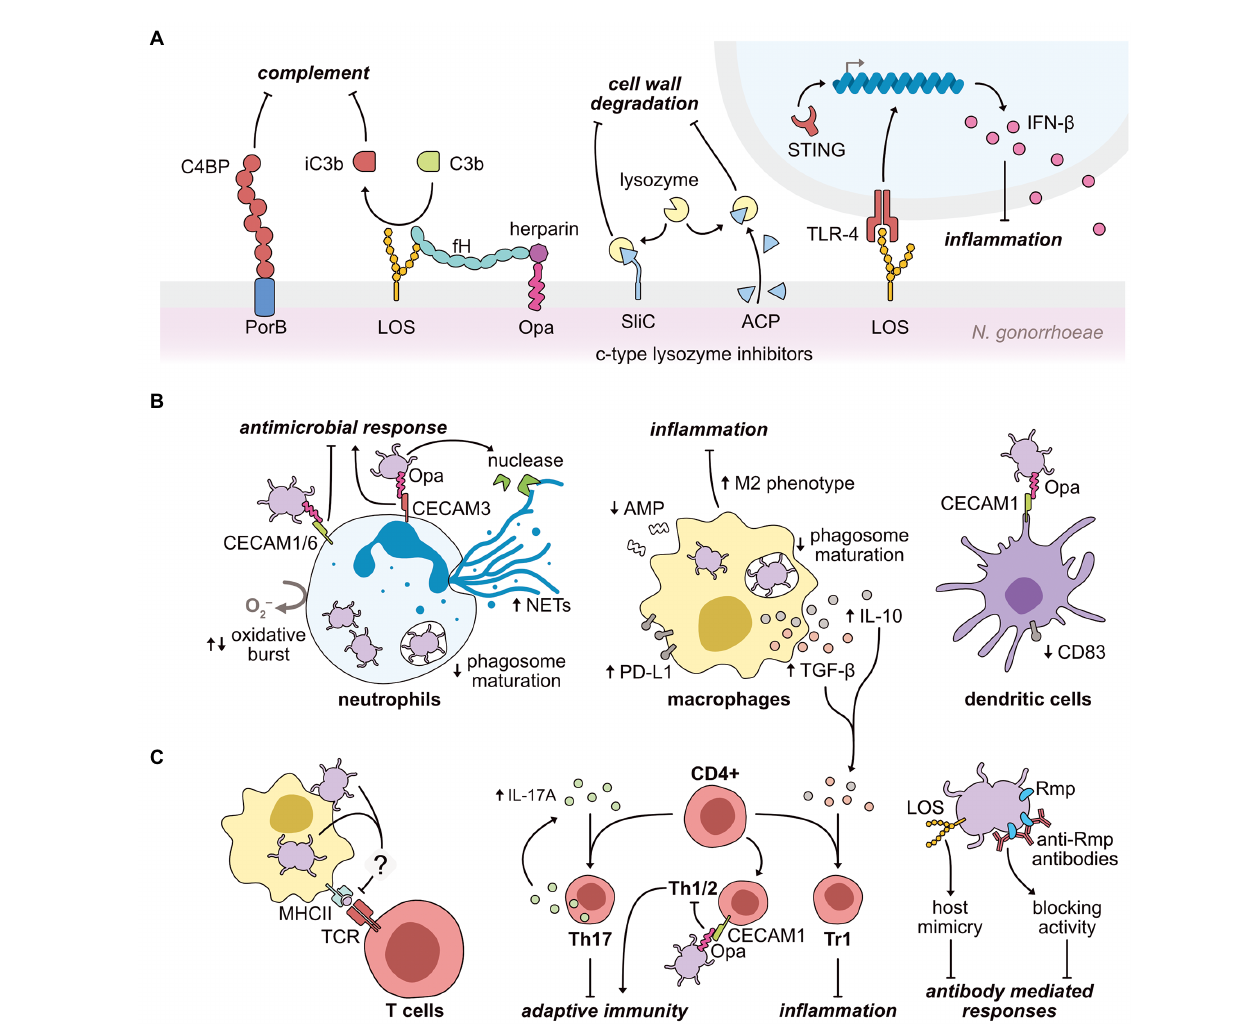
FIGURE 2 Modulation mechanisms exerted by N. gonorrhoeae on the host immune response during infection. (A) Gonococci use their primary outer membrane antigens to limit the efficacy of host lysozyme, complement, and pattern recognition systems. PorB and sialylated LOS interact with the soluble complement inhibitory proteins, C4BP and factor H (fH), respectively. LOS also binds to the soluble complement protein, C3b, inducing its inactivation (iC3b). Gonococcal Opa proteins further interact with host heparin to promote C3b inactivation. The gonococcus also expresses two surface-exposed lysozyme inhibitors (SilC and ACP), preventing the bactericidal activity of host lysozyme upon infection. In parallel, LOS interaction with the pattern recognition receptor, TLR-4, upregulates the expression of the anti-inflammatory cytokine, IFN- β . Gonococci-induced upregulation of IFN- β also occurs via activation of the cytosolic pattern recognition receptor, STING. (B) Gonococci repress antimicrobial functions of key innate effector cells to promote infection. The gonococcus engages with CEACAM receptors on neutrophils via its Opa proteins to repress (Opa-CEACAM1 and Opa-CEACAM6) or activate (Opa-CEACAM3) inflammatory responses, such as the oxidative burst. Neutrophil extracellular traps (NETs) are upregulated by gonococcal infection, although the secretion of a gonococcal nuclease may aid gonococci in resisting NET action. In both neutrophils and macrophages, gonococci are adept at delaying phagosome maturation to prolong intracellular survival. To specifically limit macrophage function, gonococci downregulates antimicrobial peptide (AMP) expression, while simultaneously upregulating immunosuppressive molecules to promote type 1 regulatory T (Tr1) cell proliferation. As part of this reprogramming, macrophages are polarized toward an anti-inflammatory M2 phenotype. Finally, Opa-CEACAM1 interactions on dendritic cells cause a downregulation of the CD83 maturation marker. (C) Gonococci act both directly and indirectly on the host adaptive immune system to minimize production of immunological memory. Gonococcal-challenged macrophages fail to increase major histocompatibility complex class II (MHCII) expression, which limits efficient antigen-presentation to cognate T cell receptors (TCRs). Instead, gonococcal infection upregulates the cytokine, IL-17A,